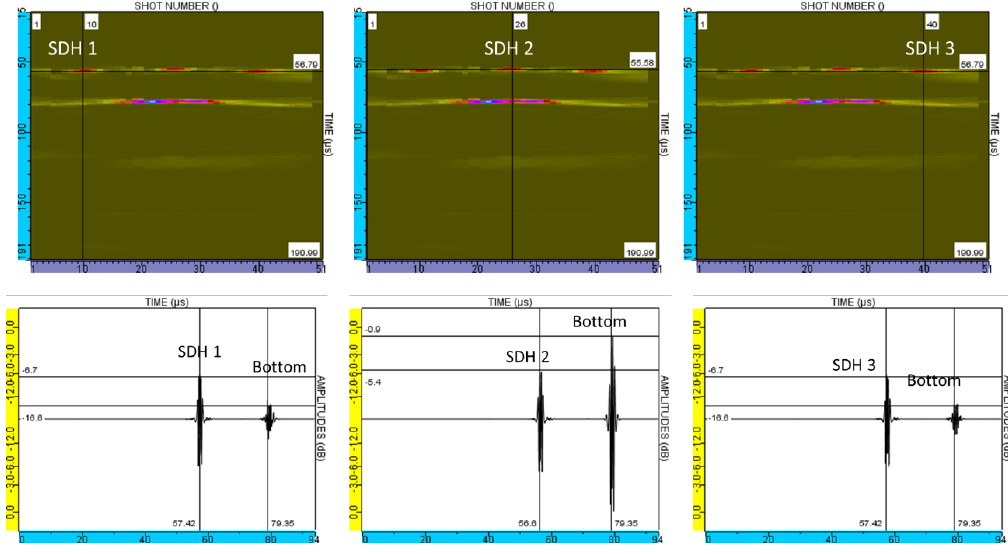
Figure 19. Simulation results with CIVA software. B-scans and A-scans of the 3 SDHs in the 250 mm aluminum block described in